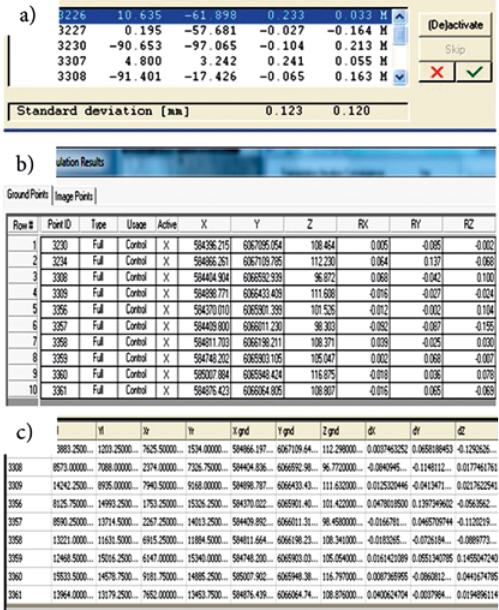
Fig. 3. Fragment of results from exterior orientation of left image on different software: a) LISA – the maximum residual